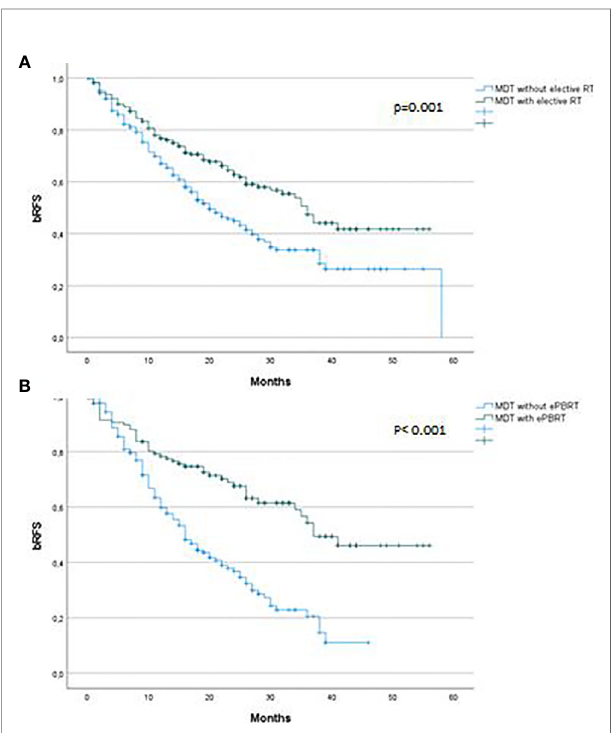
FIGURE 3 | Biochemical recurrence free survival after 68 Ga-PSMA-PET CT- directed radiotherapy of prostate cancer recurrences (A) strati fi ed by elective RT versus no elective RT, (B) strati fi ed by elective RT to prostate bed versus no elective RT to prostate bed. bRFS, Biochemical recurrence free survival; MDT, Metastasis-directed therapy; ePBRT, elective prostate bed radiotherapy.